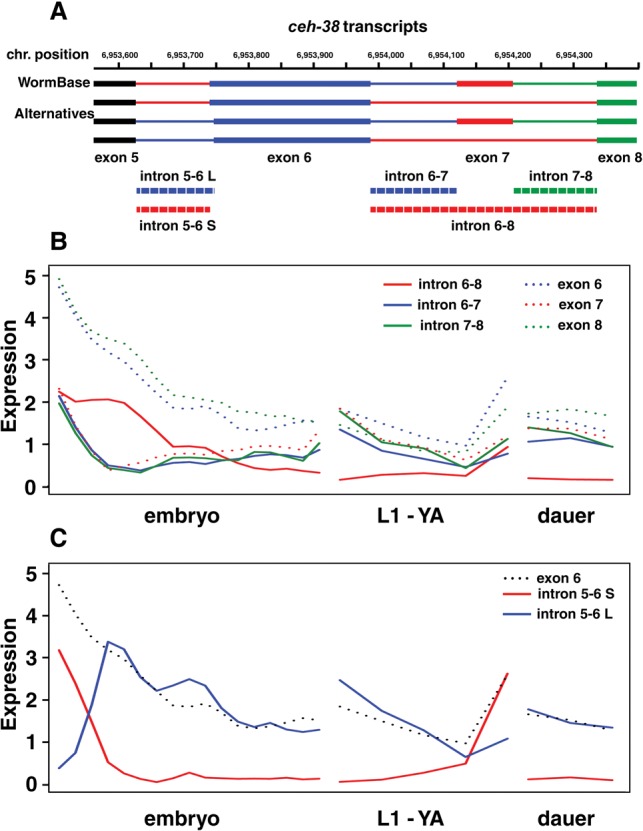
Alternative splicing in exons 5–9 of the transcription factor gene ceh-38. (A) In WormBase, only the topmost gene model is represented, using introns 5-6 S, 6-7, and 7-8 as illustrated. Our data show the presence of additional introns 5-6 L and 6-8. The former deletes two amino acids from exon 6, changing the spacing between the cut (in exon 5) and homebox (in exon 6) DNA binding domains. Intron 6-8 skips exon 7, but maintains the reading frame. (B) Expression data in dcpm for introns 6-7, 7-8, and 6-8 as well as exons 6, 7, and 8 indicate that although the included form is maternally inherited and then lost rapidly, the skipped form is expressed in the early zygote as well as maternally inherited. (C) Expression data in dcpm for introns 5-6 S and 5-6 L show that the shorter intron is maternally inherited and degraded rapidly. In contrast, the longer form has little maternal contribution, rises rapidly in the early embryo, and persists into the later embryo and larval stages, albeit at lower levels.